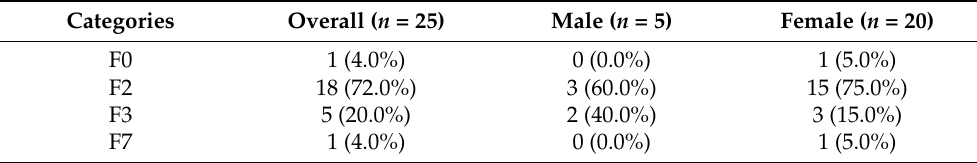
Table 2. Diagnoses (F-codes) of all participants based on the ICD-10 classification of mental and behavioral disorders.